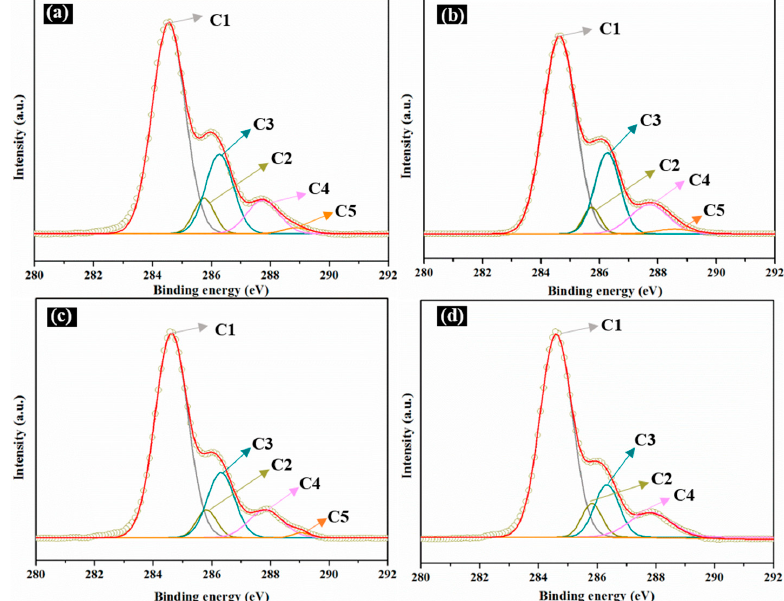
Figure 4. X-Ray photoelectron spectroscopy (XPS) of C 1s features of the SPI and PTGE film a ; SPI, PTGE, and HNTs film b ; SPI, PTGE, and CMCS film c ; SPI, PTGE, HNTs, and CMCS film d .